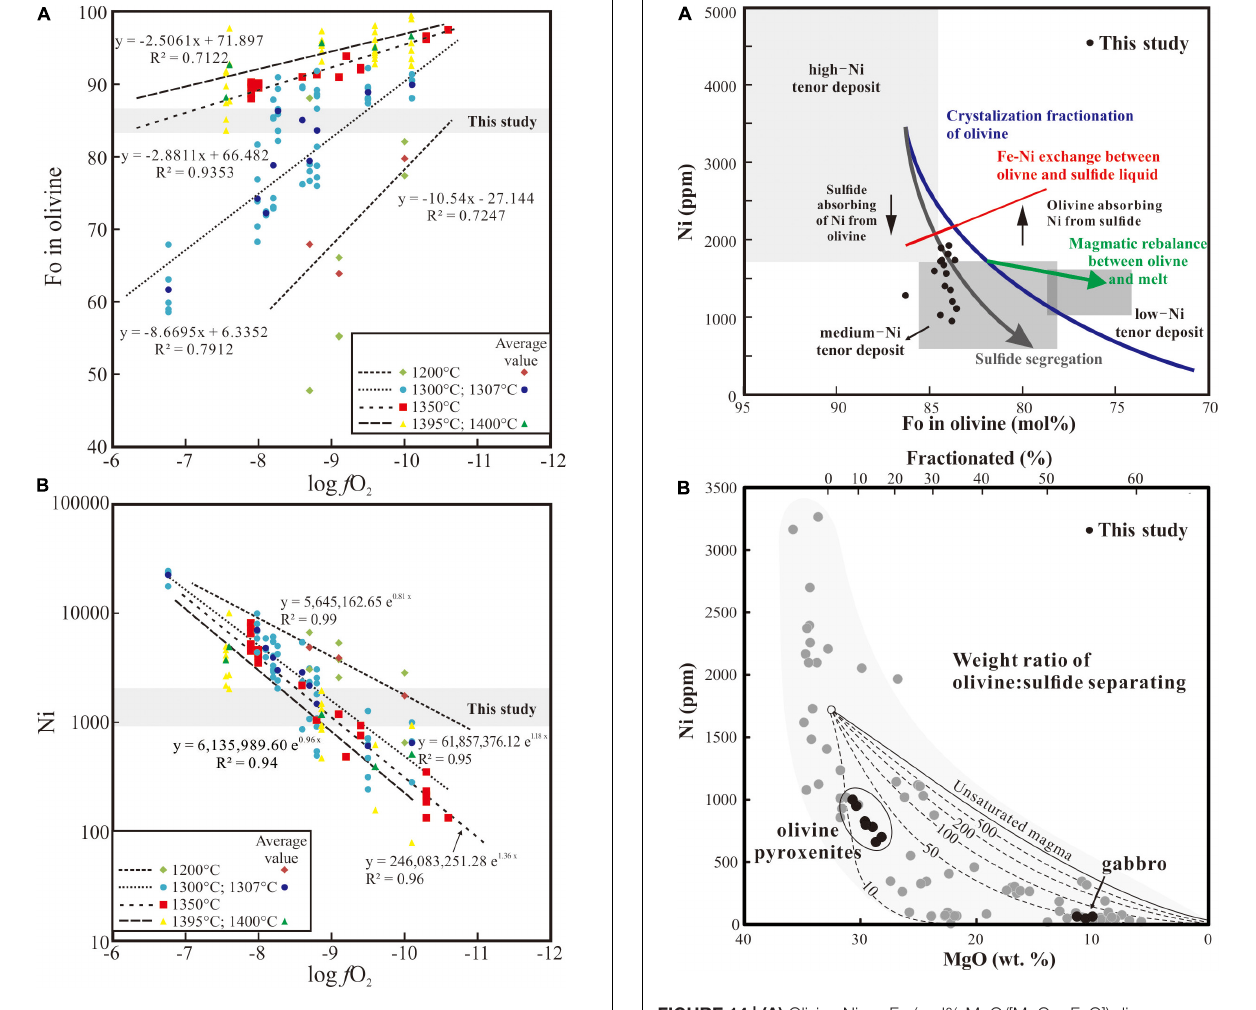
FIGURE 13 | Fo values (mol% MgO/[MgO + FeO]) (A) and Ni contents of olivines coexisting with sulfide melts (B) show relations to the variable oxygen fugacities and temperatures from various studies. Data sources of different temperatures are: 1200 ◦ C from Brenan (2003); 1300 ◦ C and 1307 ◦ C and from Fleet and Macrae (1988) and Brenan (2003); 1350 ◦ C from Gaetani and Grove (1997); 1395 ◦ C and 1400 ◦ C from Fleet and Macrae (1988) and Zhou et al. (2018).